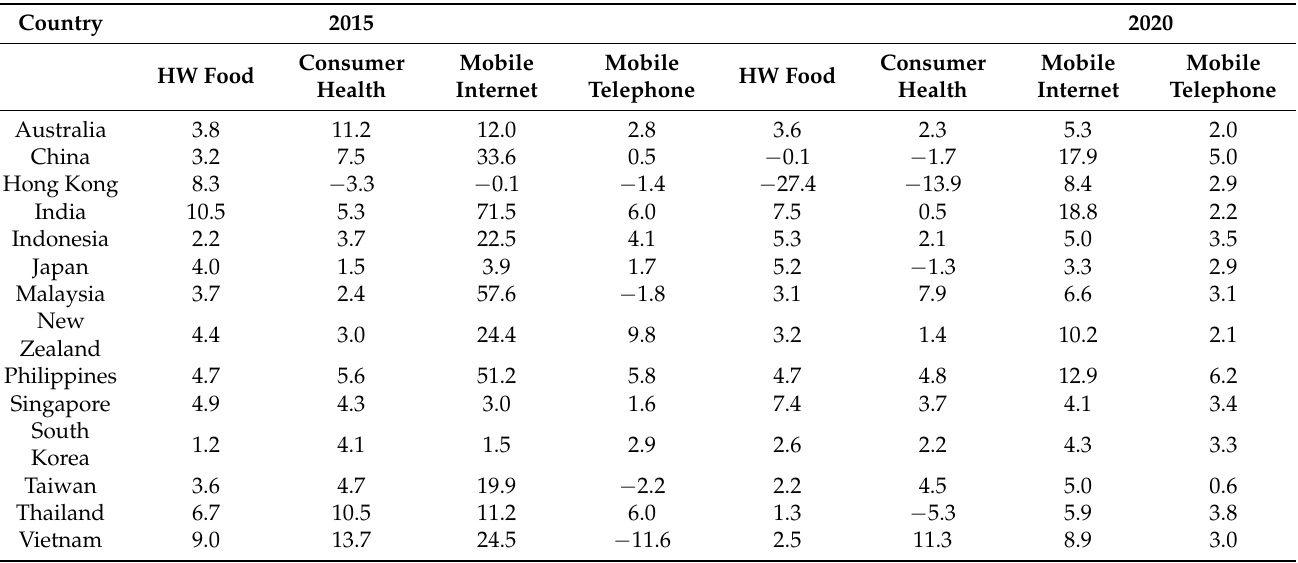
Table A3. Comparison in growth rate of in health and wellness food consumption, health consumer, mobile internet, and mobile telephone in the Asian market between 2015 and 2020 (percent).